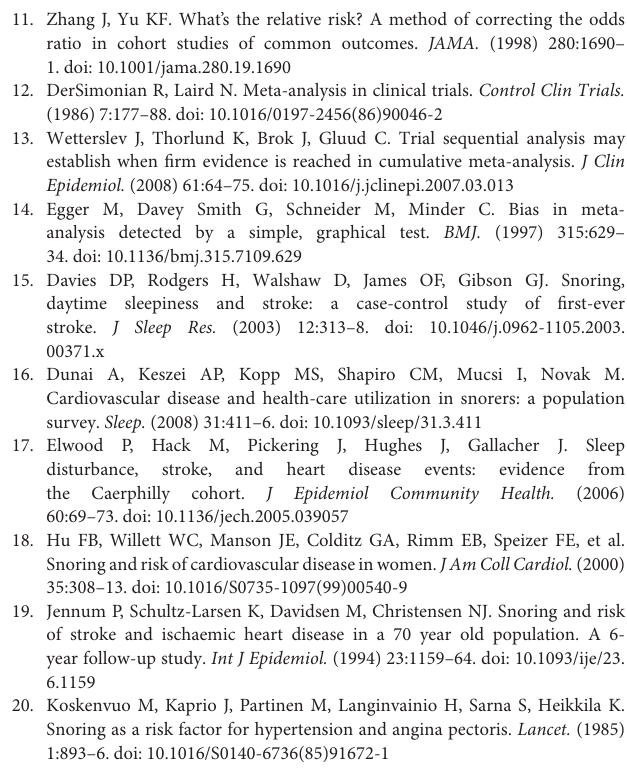
Supplementary Table 2 | Newcastle Ottawa Scale for quality